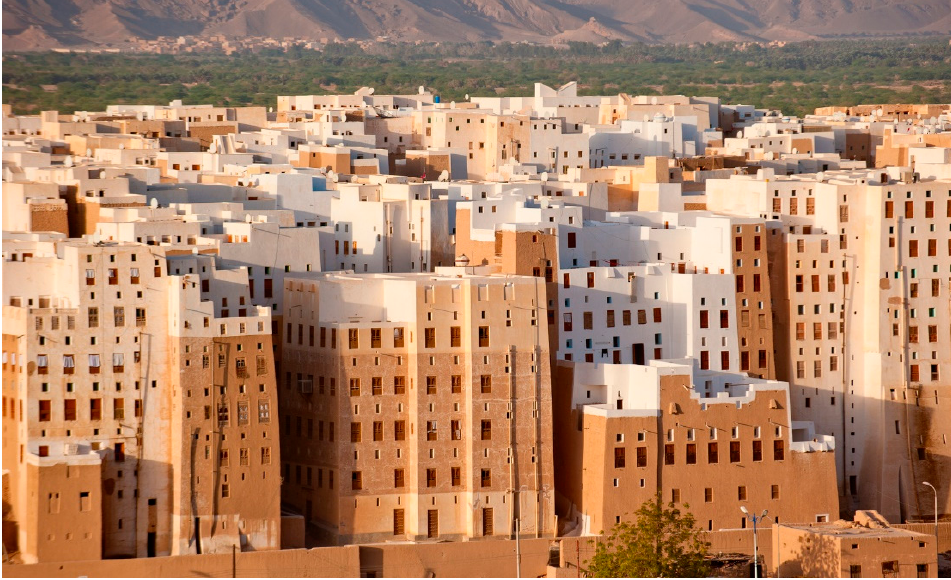
Figure 3. City of Shibam, Yemen. The city whose buildings were mostly erected with construction technologies using earth.